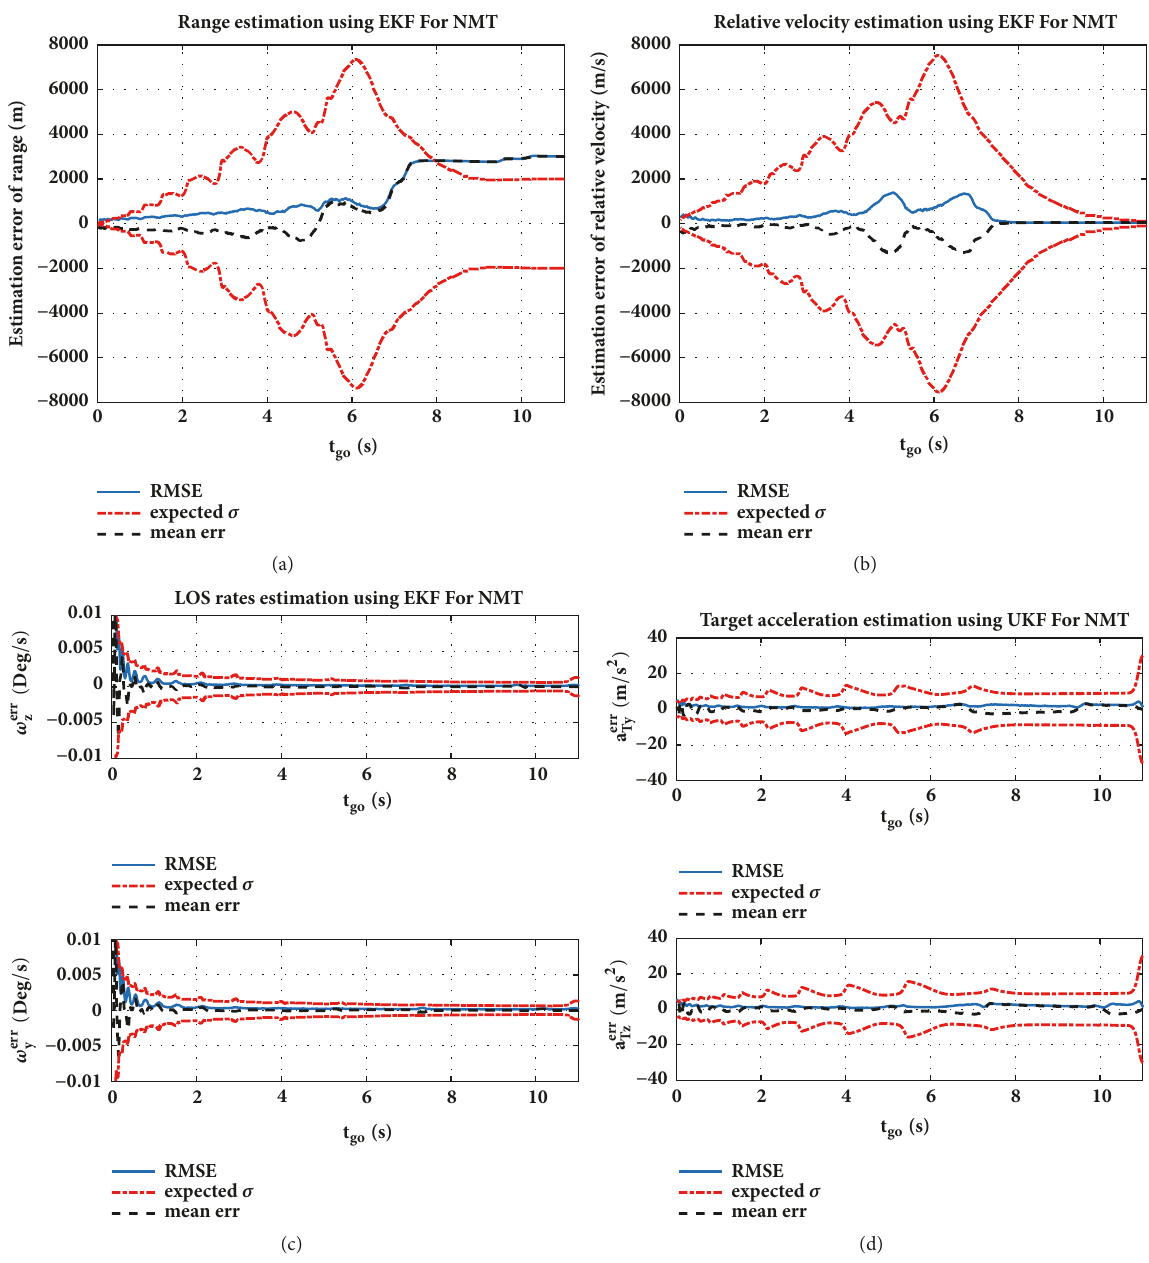
Figure6:(a)RangeestimationerrorsusingEKFforNMT.(b)RelativevelocityestimationerrorsusingEKFforNMT.(c)LOSratesestimation errors using EKF for NMT. (d) Target acceleration estimation errors using EKF for